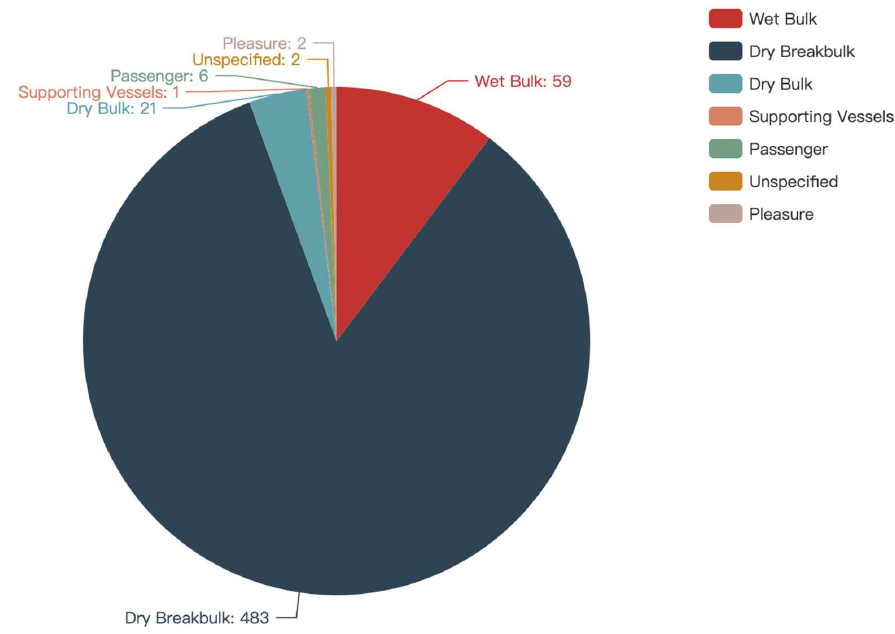
Figure 8. A pie chart of the ship types in Chongqing Port.